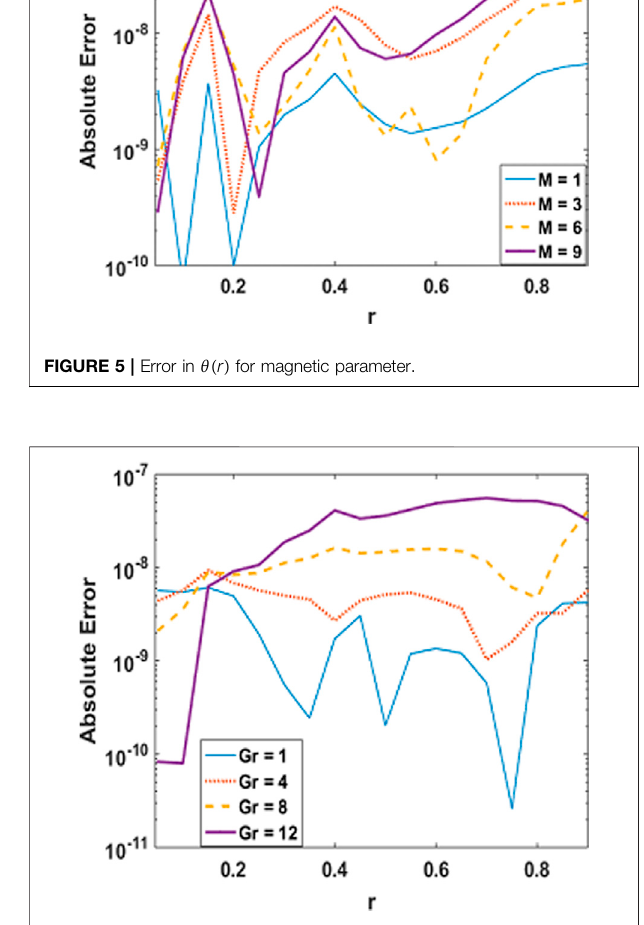
FIGURE 6 | Error in H 3 (r) for Grashof